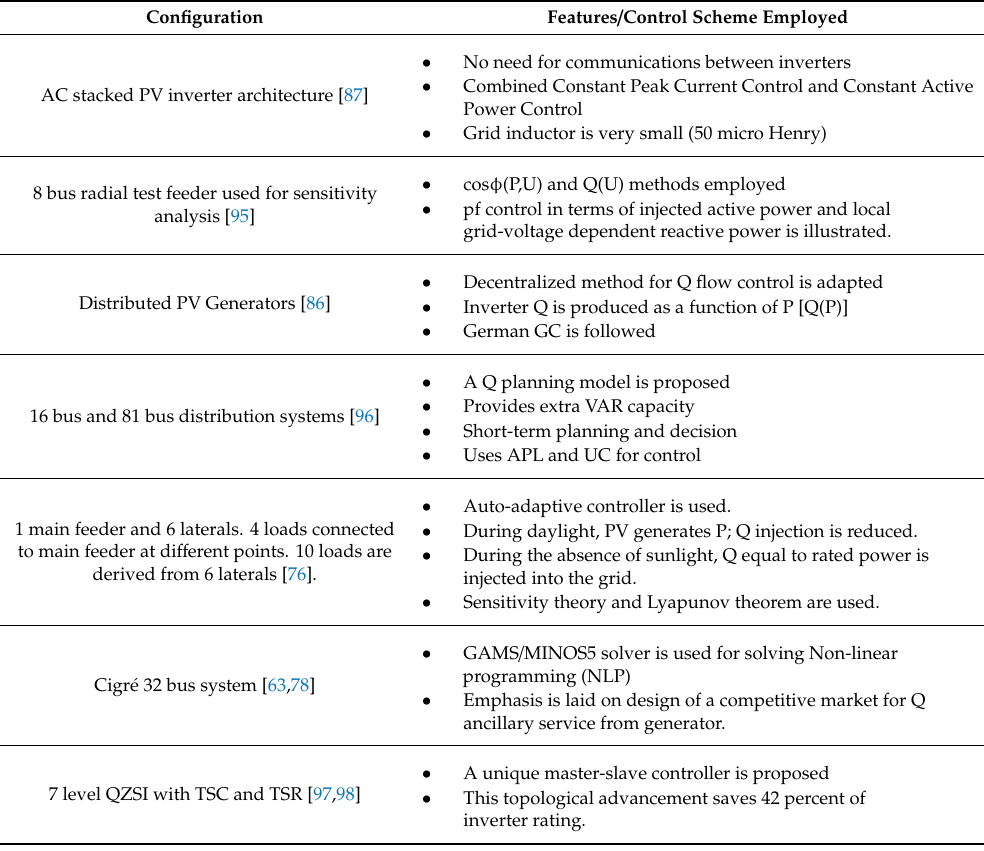
Table 8. A summary of control techniques